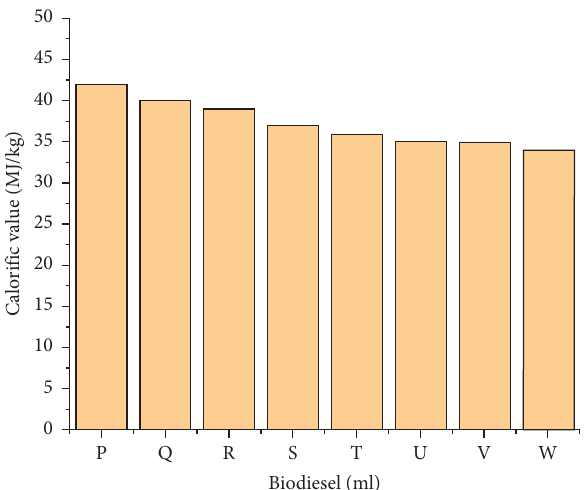
Figure 4: Te density of the fuel with varying biodiesel volumes.